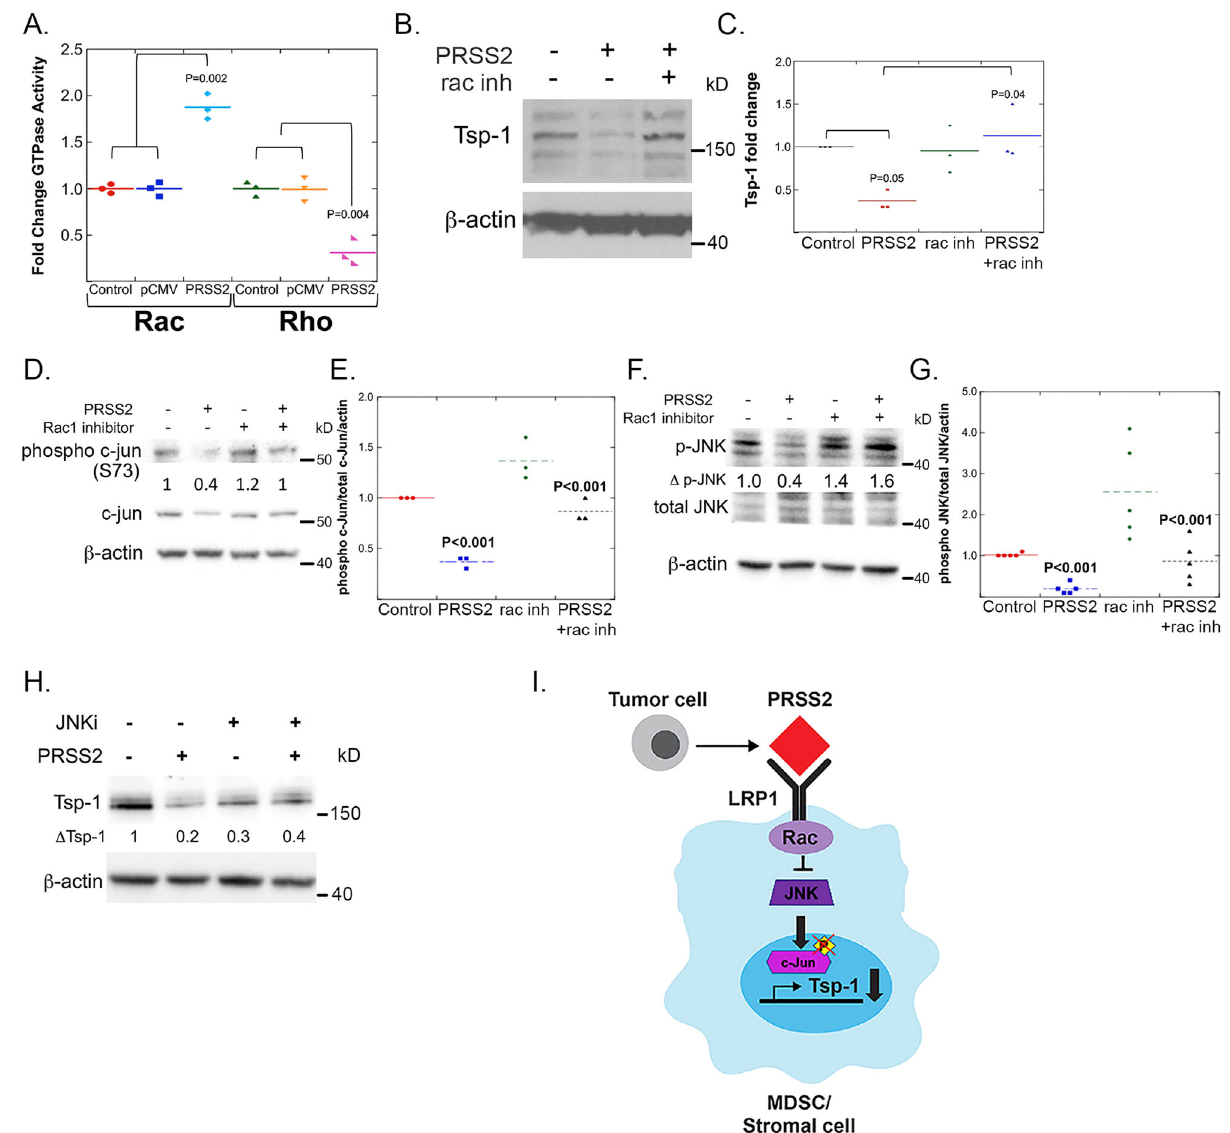
Fig.3|PRSS2repressesTsp-1byactivatingRacdownstreamofLRP1.A Dotplot ofGTP-boundRacandRhoinWI38cellsthatwereuntreated(control),treatedwith CMfrom293Tcellstransfectedwithemptyvector(pCMV)orPRSS2(PRSS2)( n =3; P value calculated via two-sided Student ’ s t test). B Western blot of Tsp-1 and actin expression in WI38 cells that were untreated ( – ) or treated with PRSS2 (+) in the absence( – )andpresence(+)ofasmallmoleculeinhibitorofRac1NSC23766( n =3). C Dot plot of quantitation of Tsp-1 western blots from all replicates of WI38 that were untreated( – ) or treatedwith PRSS2 (+) inthe absence( – ) and presence (+) of NSC23766 ( n =3; P value calculated via two-sided Student ’ s t test). D Western blot ofphosphoc-Jun,totalc-JunandactininWI38cellsthatweretreatedwithsaline( – ), PRSS2, Rac1 inhibitor NSC23766, or PRSS2 and NSC23766 in combination ( n =3).